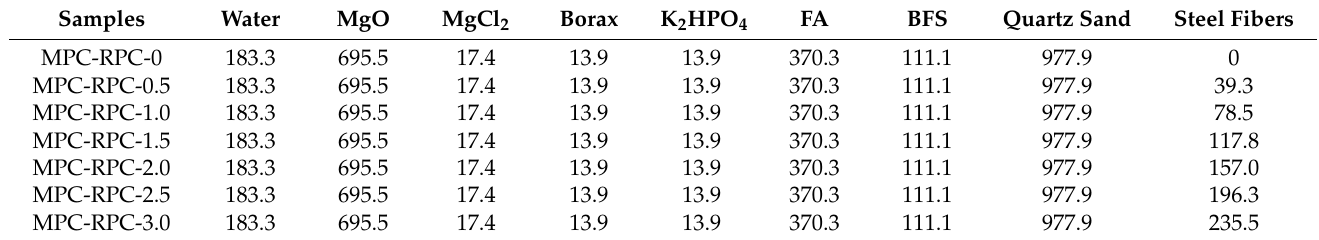
Table 3. The mix of RPC per unit volume (kg/m 3